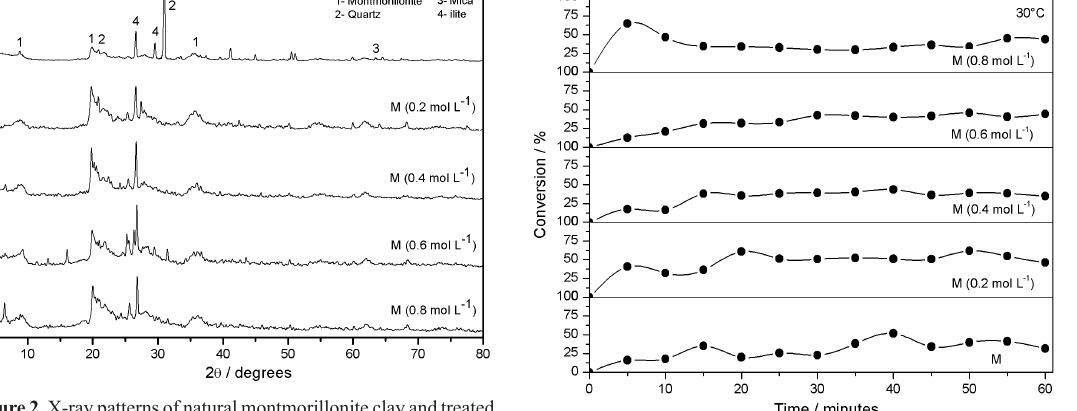
Figure 2. X-ray patterns of natural montmorillonite clay and treated montmorillonite clay (0.2– 0.8 mol L –1 ). Figure 3. Conversion of oleic acid at 30 °C, using natural montmorillonite clay and treated montmorillonite clay with sulfuric acid at different concentrations (0.2 – 0.8 mol L –1 ).